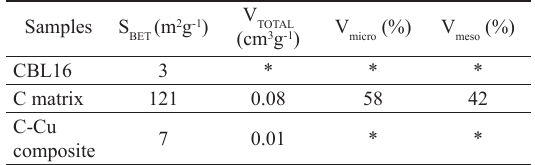
Table 1. Surface area and pore volume of the CBL16, C matrix and the C – Cu